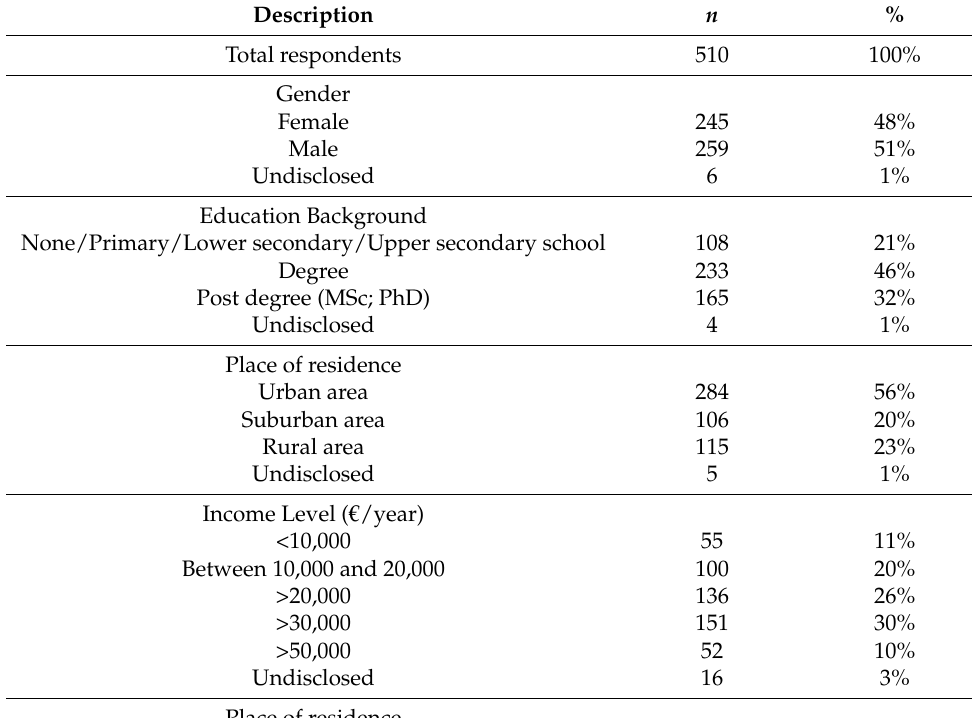
Table 2. Description and distribution of the sample; 510 respondents.